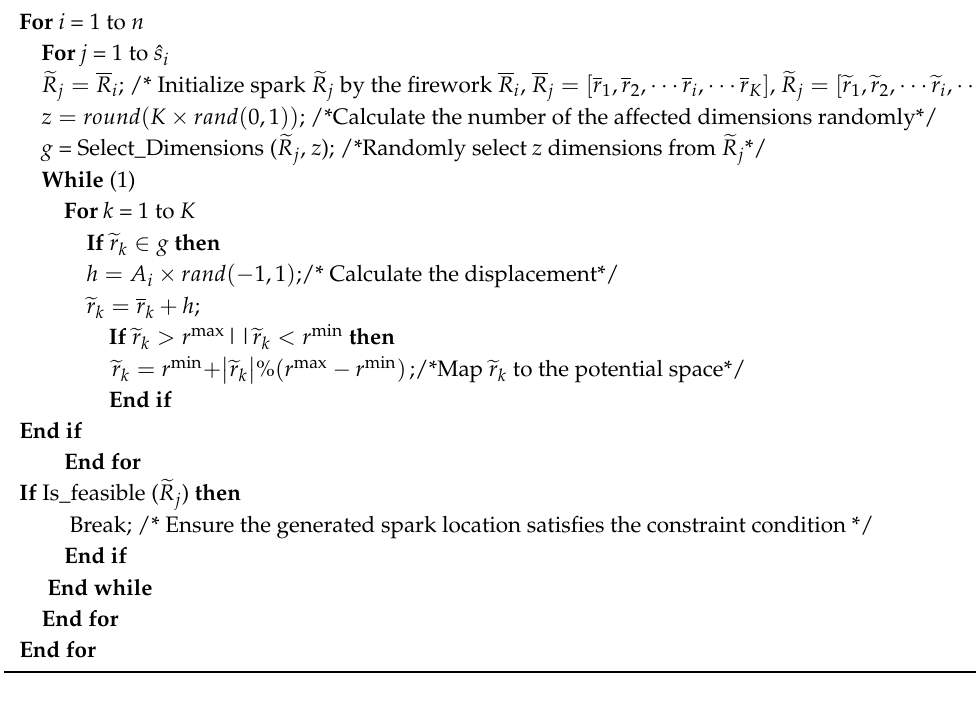
Algorithm A1 Generate the locations of general sparks